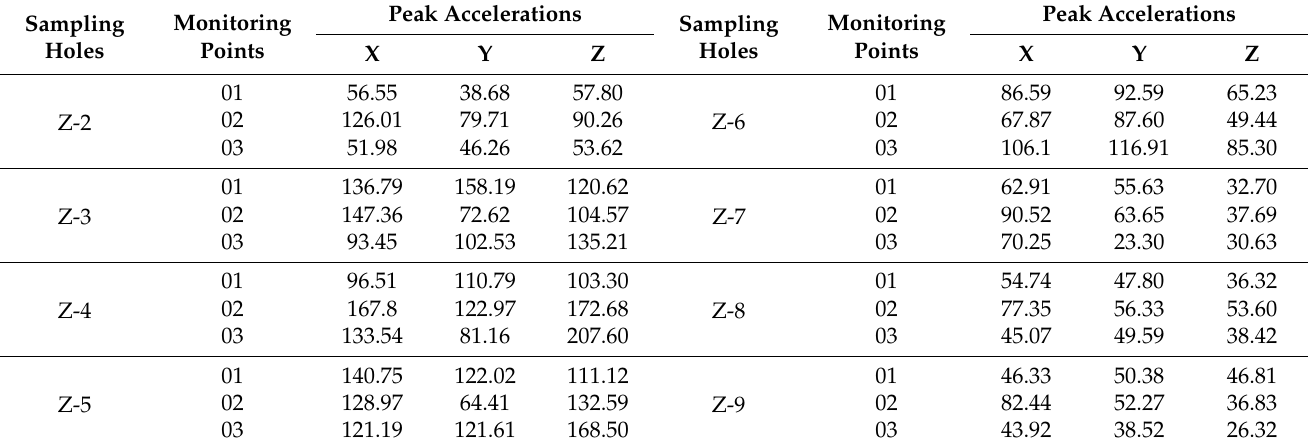
Table 3. Peak accelerations of measuring points in the transverse section (unit: mm/s 2